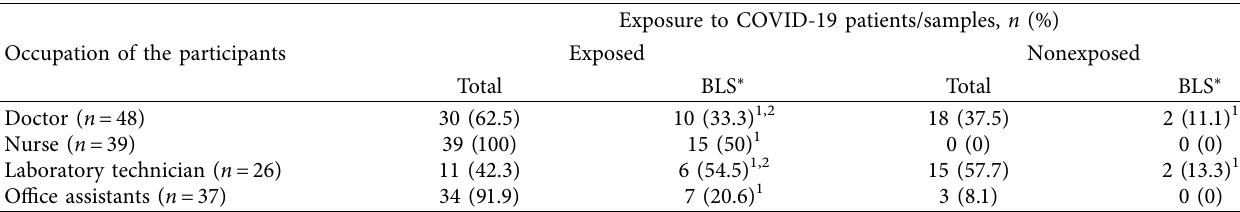
Table 3: Baseline SARS-CoV-2 seropositivity among HCWs based on their exposure to COVID-19 patients or samples. Exposure to COVID-19 patients/samples, n Occupation of the participants